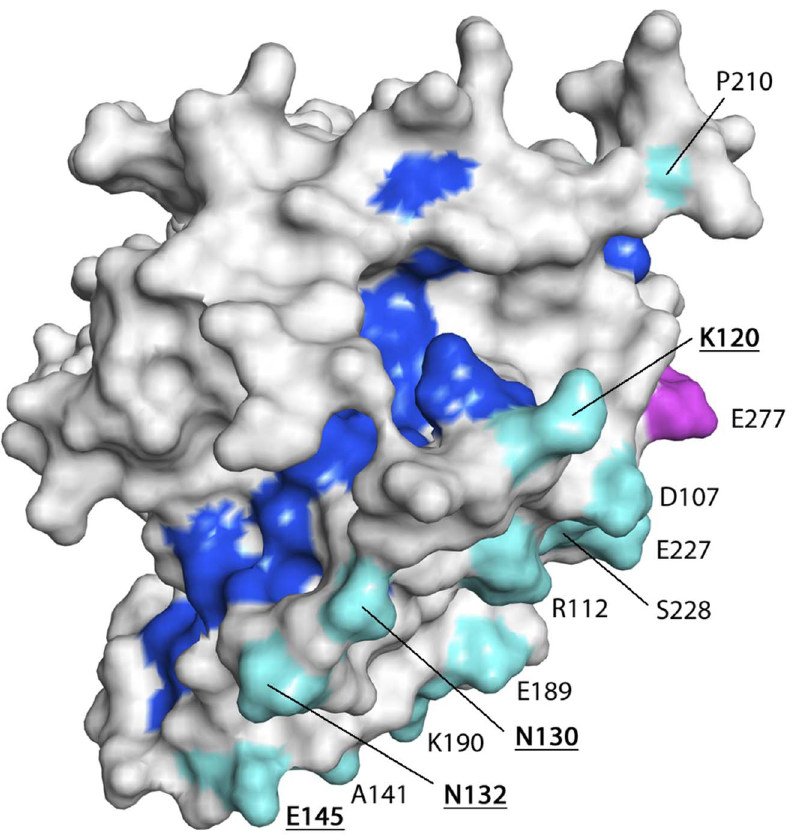
Figure 4. Proximity of the Pv AMA1 residues under selection to the hydrophobic ligand-binding cleft. Solvent-accessible surface representation of the Pv AMA1 model showing a top-view of the hydrophobic ligand-binding cleft. Binding cleft residues are highlighted in dark blue, DI polymorphic residues in cyan and a DII residue in magenta. Residues labeled with bold, underlined type are located in close proximity to the cleft and are predicted to be of functional importance.